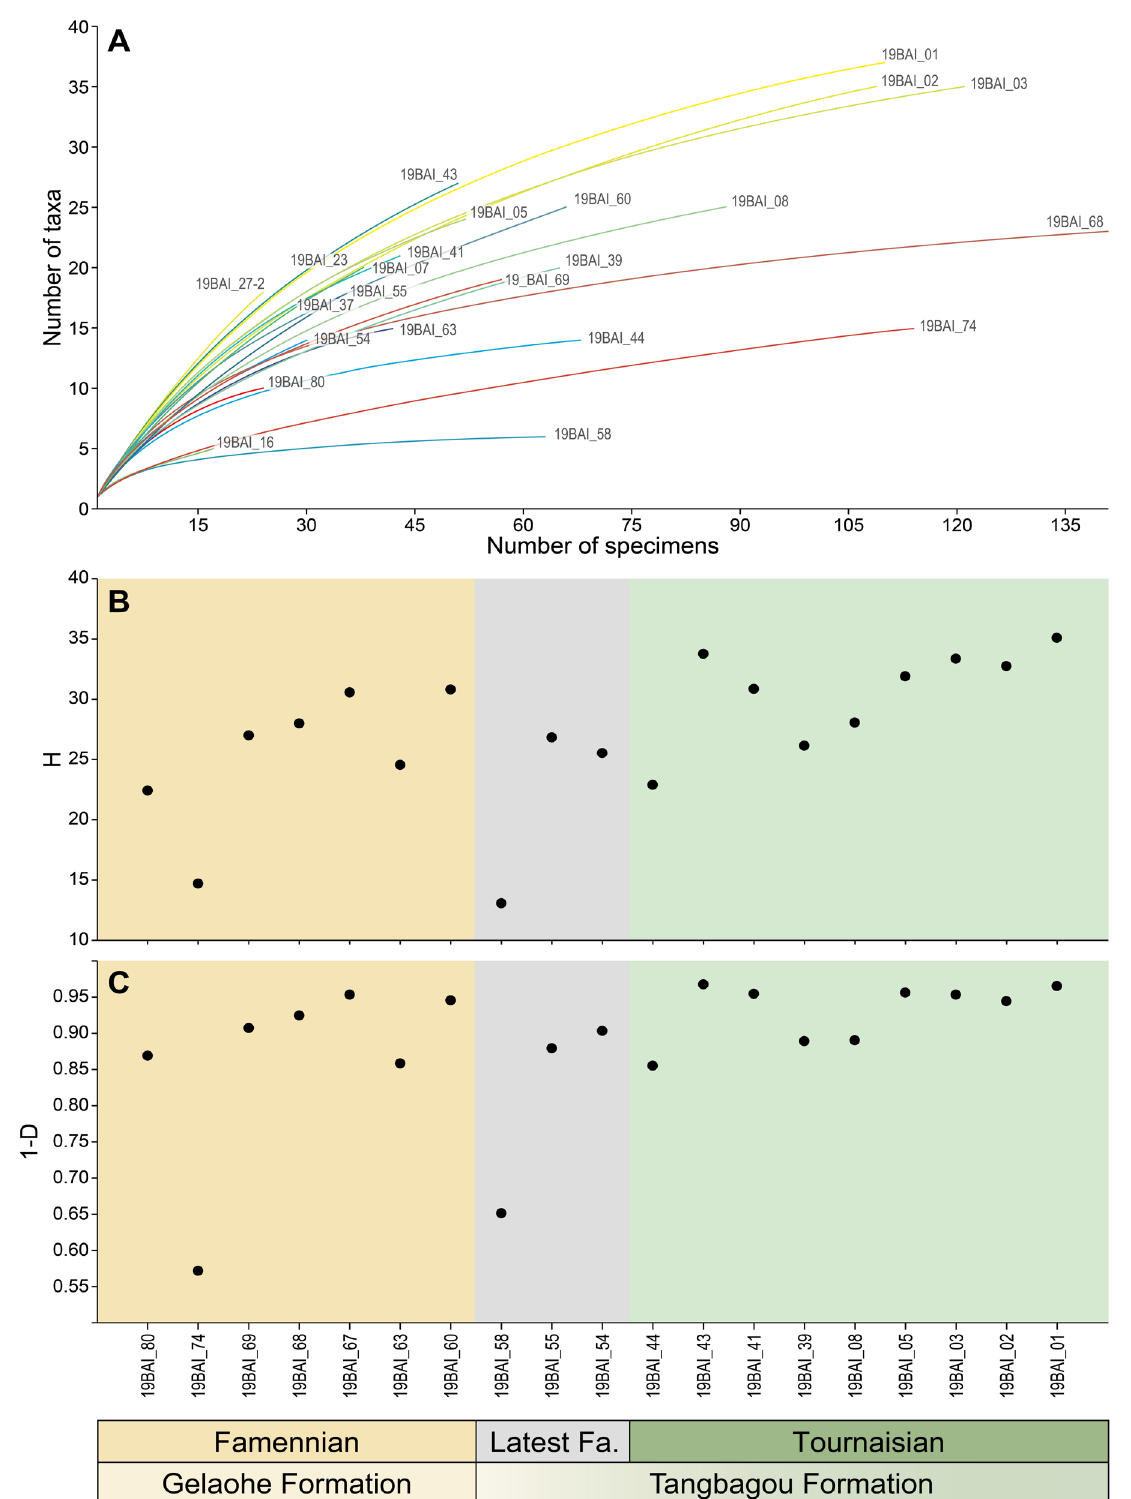
Fig. 12. Individual rarefaction curves (A) and evolution of the Shannon-Wiener (B) and Simpson indices across the Blue Snake section. Orange: Association A. Grey: Association B. Green: Association